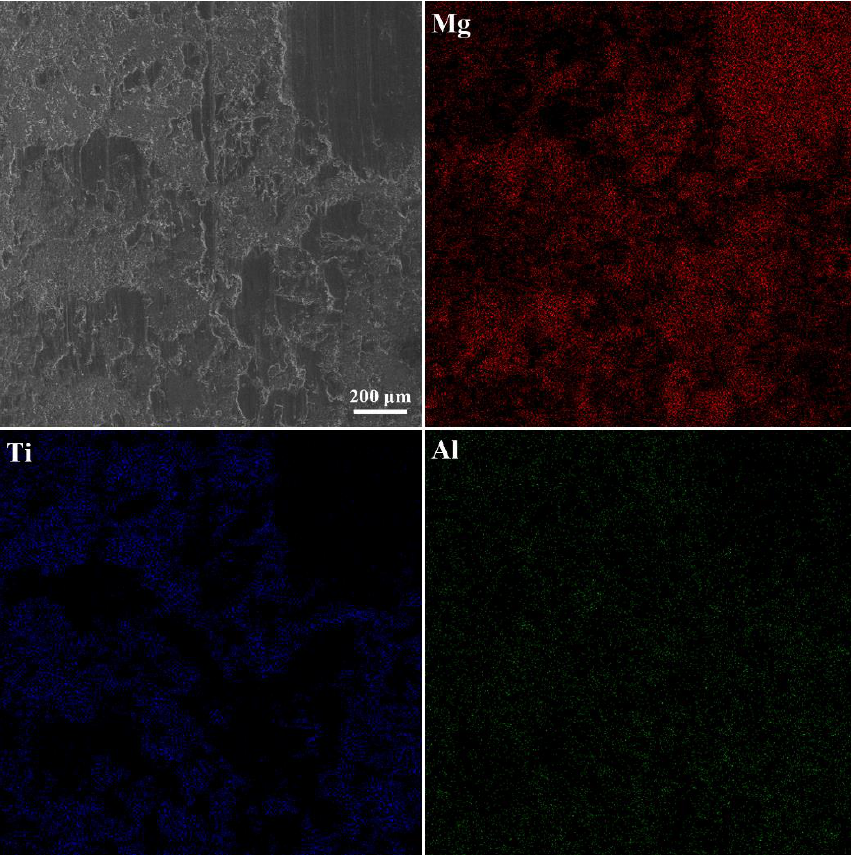
Figure 9. BSE-EDS mapping of Mg, Al and Ti elements for the fracture surface of Ti rod at 700 °C for 60 min.